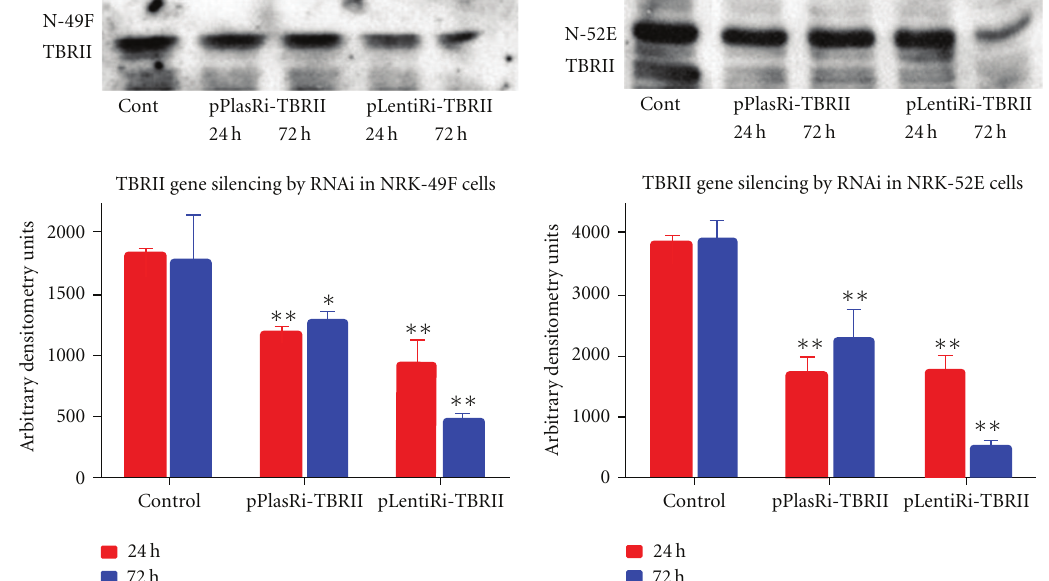
Figure 3: Gene silencing of TBRII in renal epithelial and fibroblast cells by RNAi. At 24 and 72 hrs post pPlasRi-TBRII and pLentiRi-TBRII transfection, Western immunoblots for renal fibroblasts (NRK-49F), and epithelial cells (NRK-52E) showed specific inhibition of TBRII. Both RNAi plasmids significantly inhibited TBRII at 24 and 72 hrs post transfection; however, both fibroblast and epithelial cell lines had stronger gene silencing with pLentiRi-TBRII at 72 hrs ( ∗∗ P < . 01 and ∗ P < . 05, resp., in comparison with controls). Scale bar in each photomicrograph = 100 μ